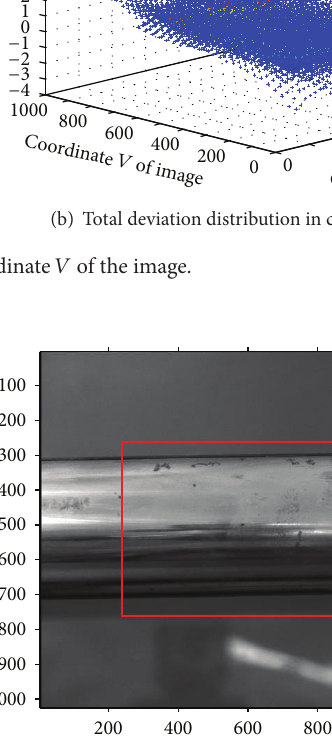
(2) two edges of the shaft are detected using sub-pixel edge detection method [17–19], and the pixel coor- dinates of edge points are corrected by the distortion correction functions; (3) two parallel lines are fitted using the corrected points in the plane of pixel, and pixel distance between the two lines can be obtained.